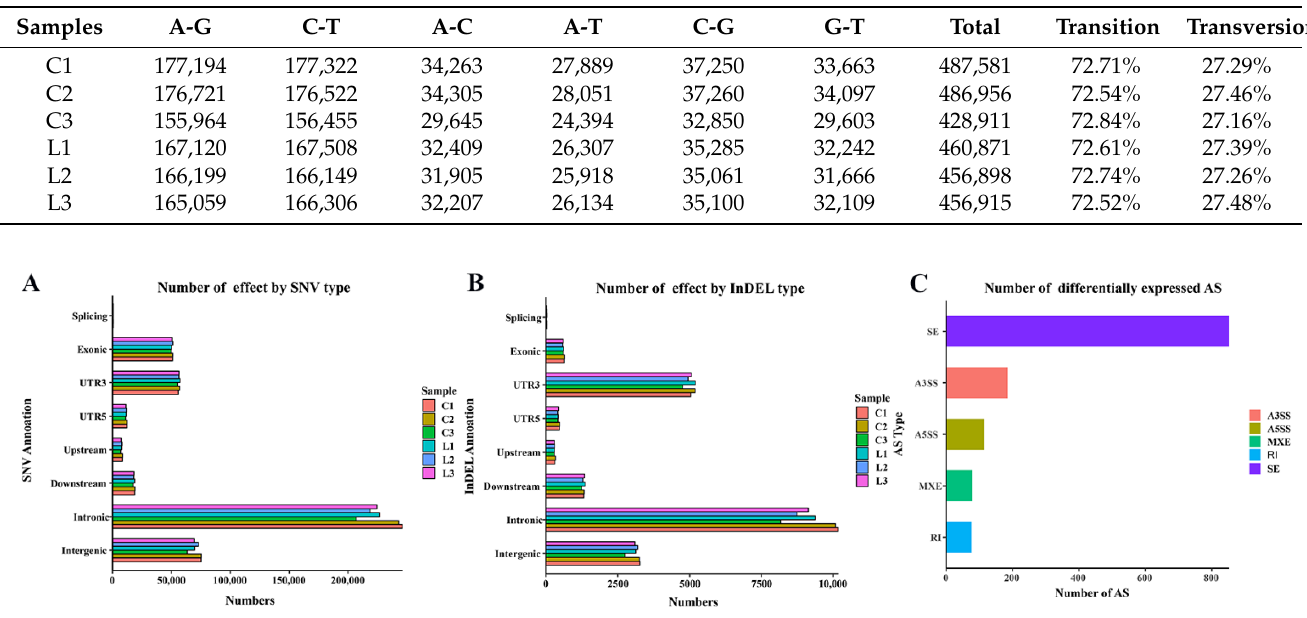
Table 2. SNV mutation types from goose livers.